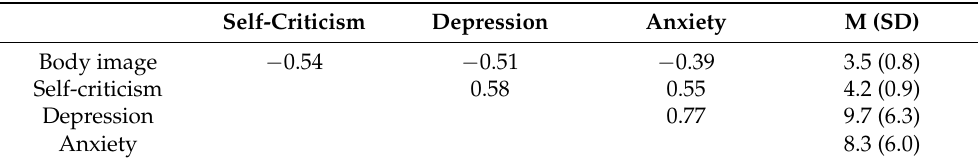
Table 2. Correlations between the study variables (all p ’s < 0.001), means, and standard deviations.